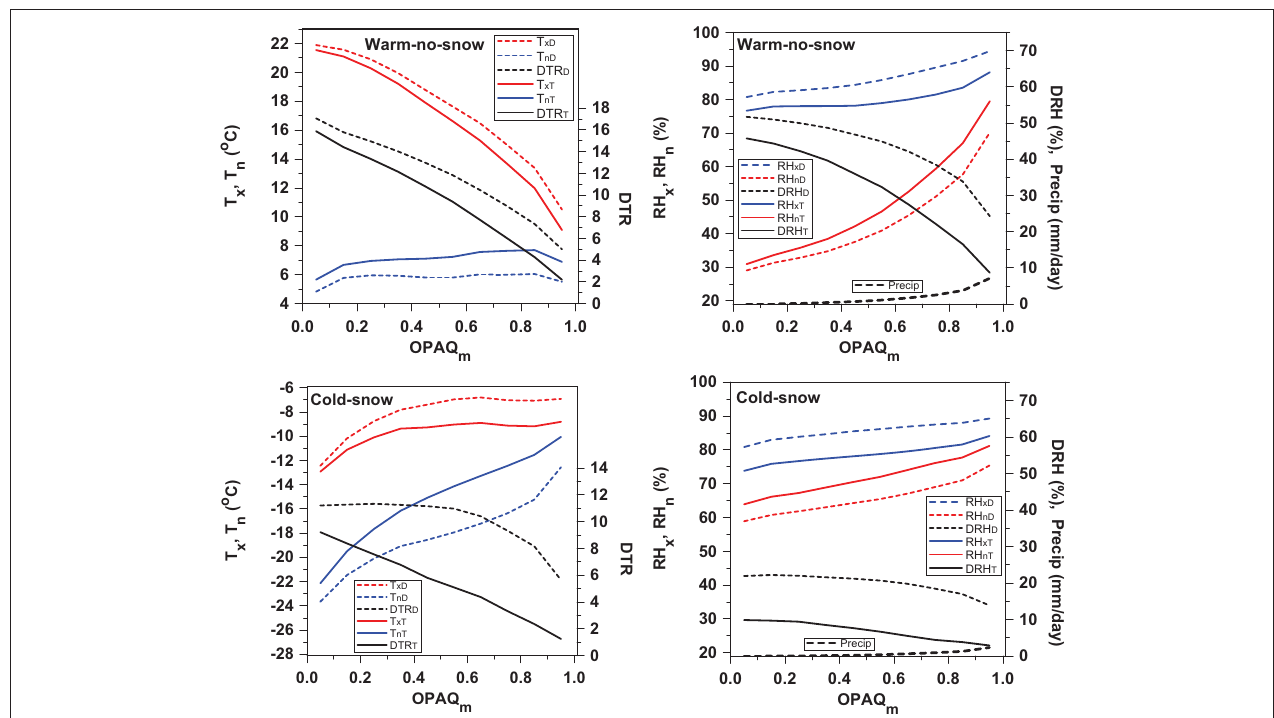
FIGURE 12 | T x , T n , and DTR (left) and RH x , RH n , DRH and daily precipitation (right) for the warm-no-snow (top) and cold-snow (bottom). Solid lines come from Figures 7 , 8 , while the dashed lines are the corresponding means of the daily values.